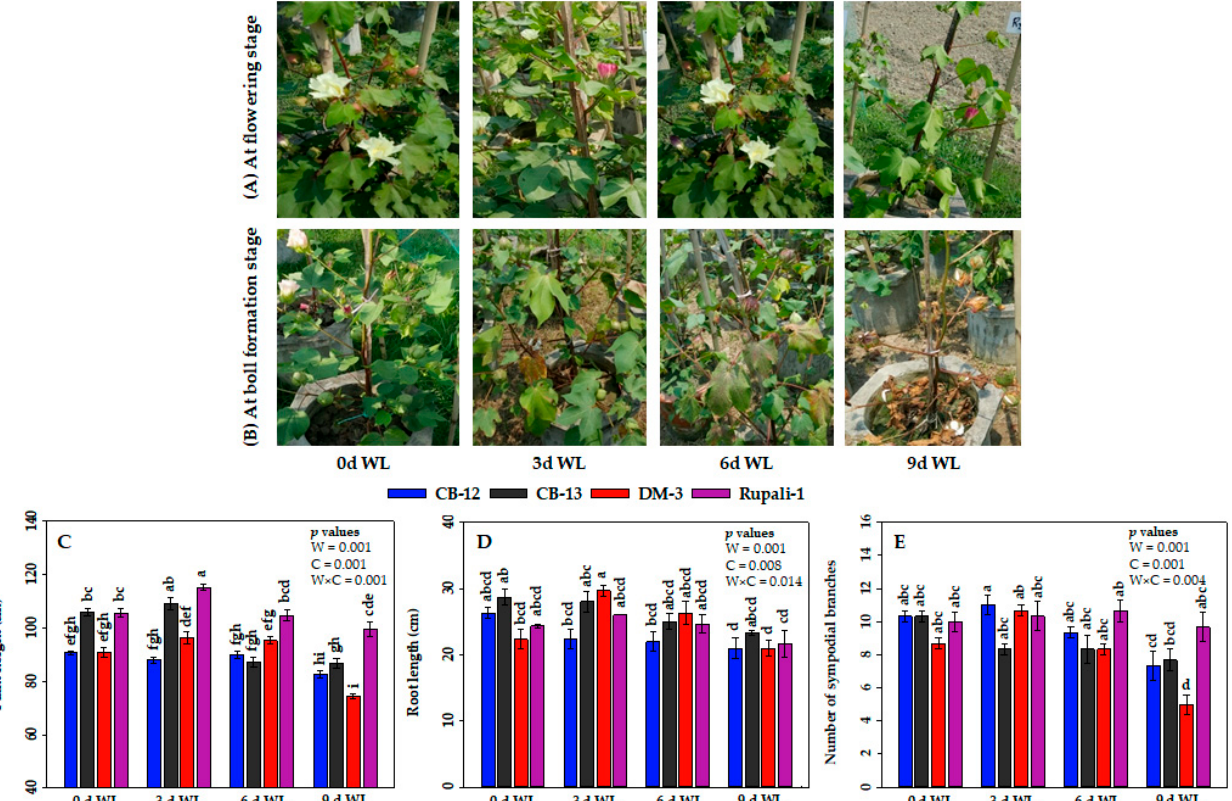
Figure 1. Phenotypic differences of cotton plants under different waterlogging (WL) conditions ( A , B ). Effect of WL on ( C ) plant height, ( D ) root length, and ( E ) number of sympodial branches. Values are means ± standard errors. Bars connected with different letters have significant differences. p values are presented at the top right corner of the graphs. W = WL duration, C = cotton cultivar and W × C = interaction of WL duration and cotton cultivar. d; day(s).